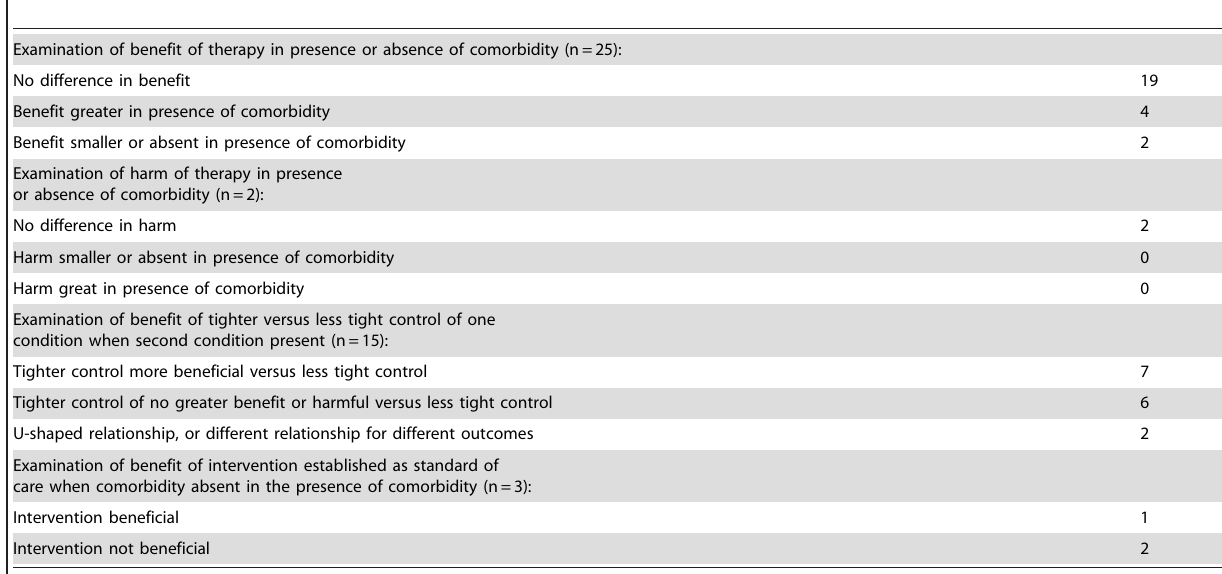
Table 2. Main study findings according to approach of